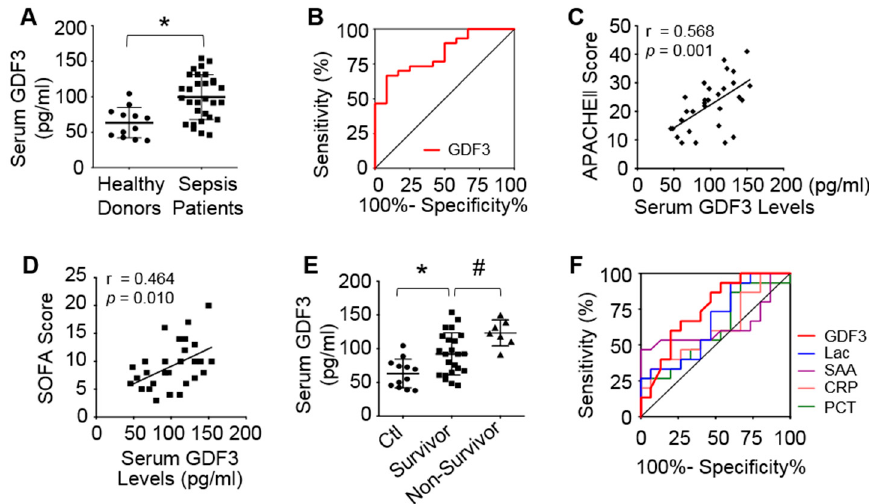
Figure 1. Higher serum levels of GDF3 are related to poor outcomes of septic patients. ( A ) Scatter plots of serum GDF3 levels on admission of healthy donors and septic patients. ( B ) AUC discriminating sepsis from healthy controls. ( C , D ) Correlation between serum GDF3 levels and ( C ) APACHE II score and ( D ) SOFA score at admission of ICU. ( E ) Serum GDF3 levels in different groups sorted by survivor and non-survivor. ( F ) AUROC predicting 28-day mortality: GDF3 (AUC 0.770), Lac (AUC 0.767), CRP (AUC 0.632), PCT (AUC 0.677), SAA (AUC 0.724). (*, p < 0.05 vs. healthy donors; #, p < 0.05 vs. survivor).